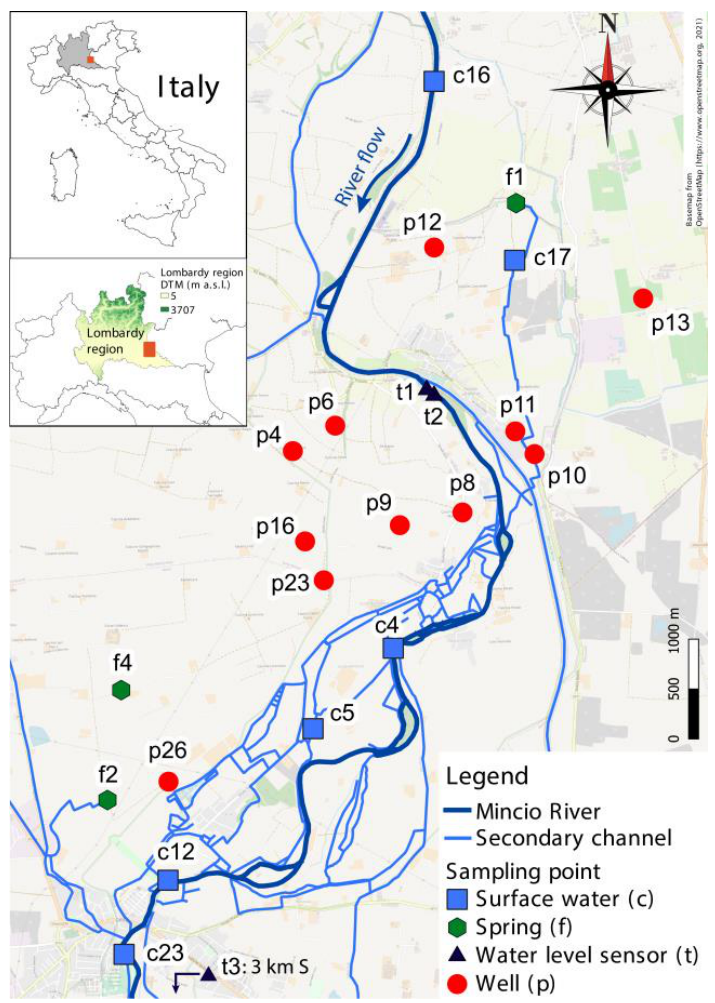
Figure 1. Schematic map of the investigated area and sampling points. In the corner, the Lombardy region is highlighted and its digital terrain model (DTM) is reported, with the investigated area indicated by the red rectangle. Basemap from OpenStreetMap (https://www.openstreetmap.org, accessed on 6 December 2021).